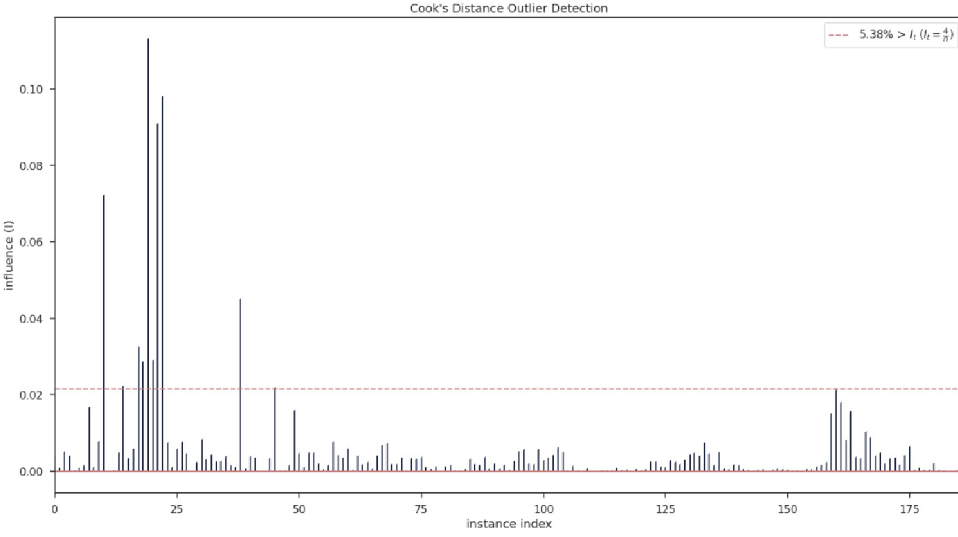
Fig 3. Demonstration of Cook’s distance outlier detection.